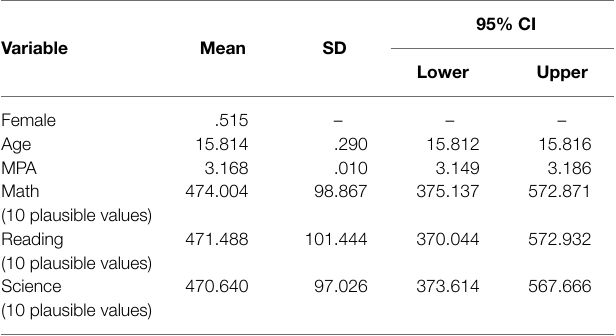
TABLE 1 | Demographic information of participants and descriptions of predictor and outcome variables ( N =